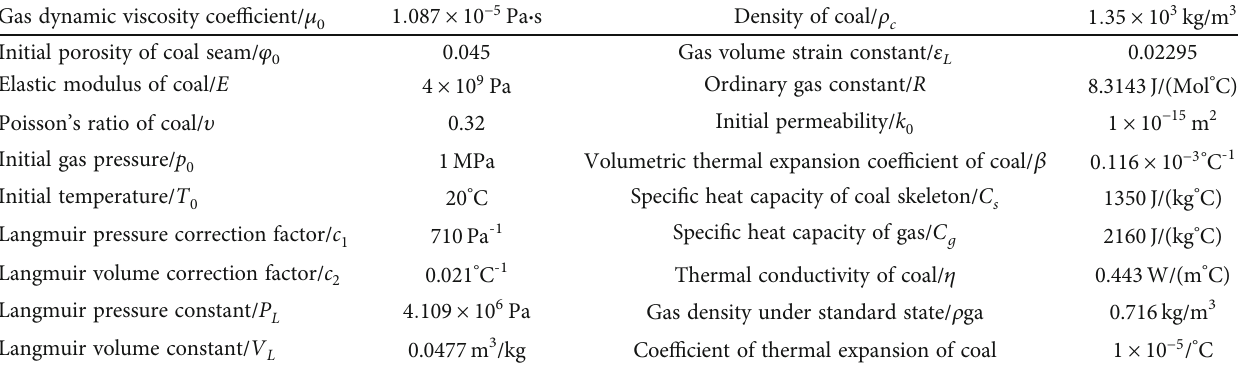
Figure 1: Calculation model of coal seam damage under thermal- fl uid-solid coupling. Table 1: Basic parameters of numerical